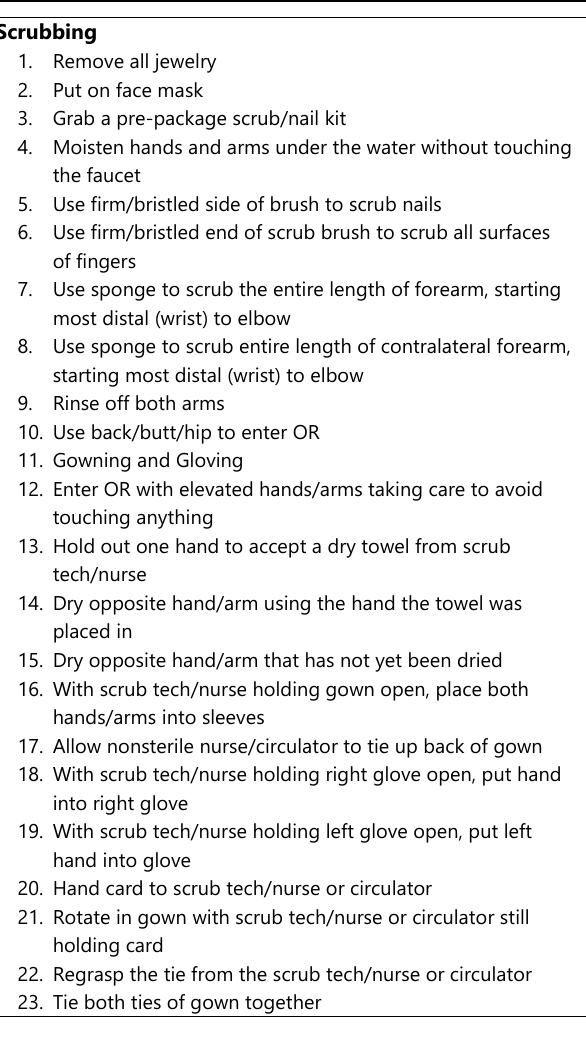
Table 1. Scrubbing, Gowning and Gloving (SGG) Checklist.